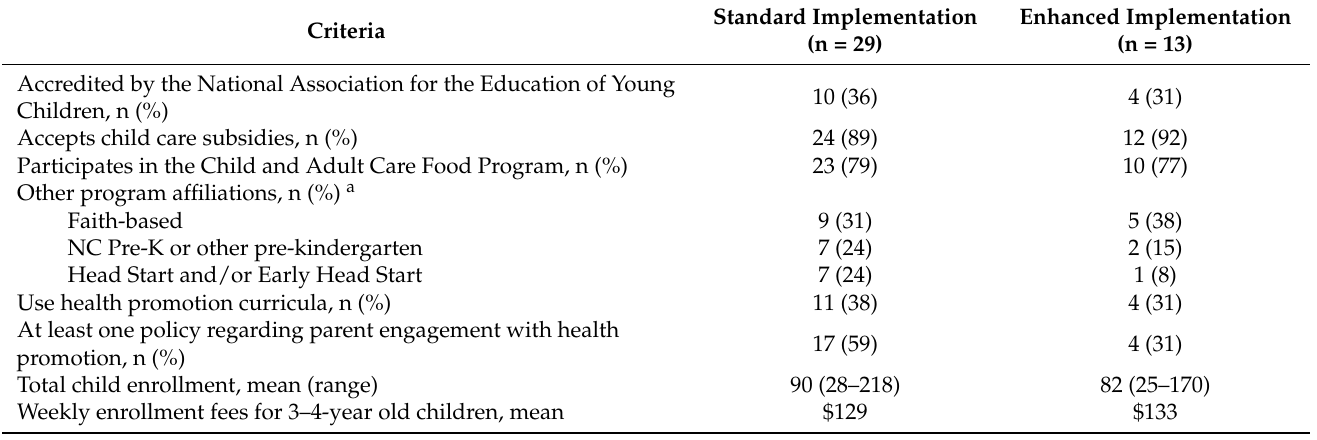
Table 4. Characteristics of 42 early care and education centers implementing Healthy Me , Healthy We